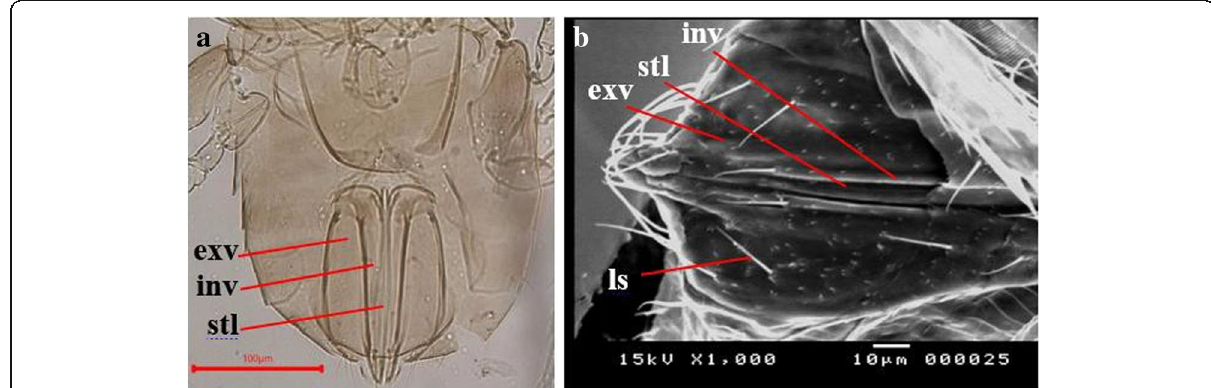
Fig. 8 Ovipositor of TNV: a light micrograph of female ovipositor ventral view. b SEM ventral view ( exv external valves, inv internal valves, stl stylet and ls long